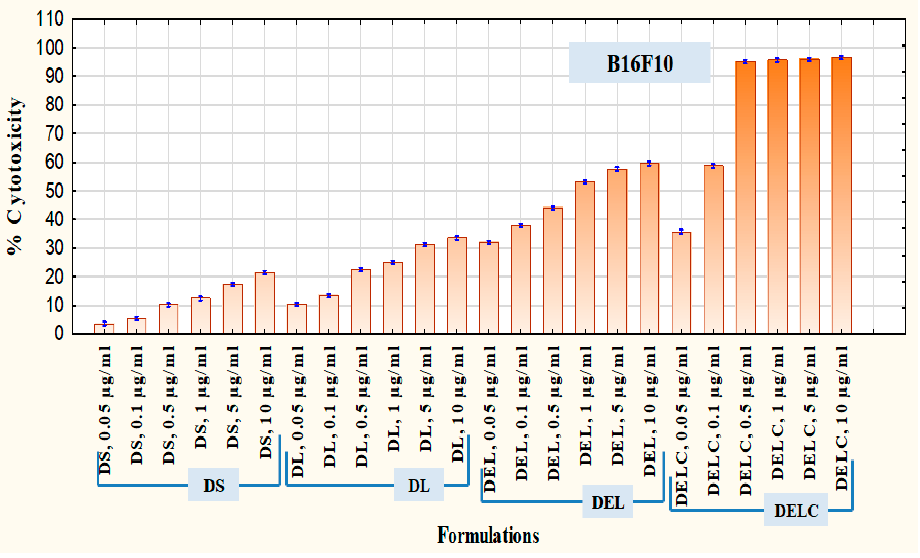
Figure 13. Cytotoxicity in B16F10 Melanoma Cells.